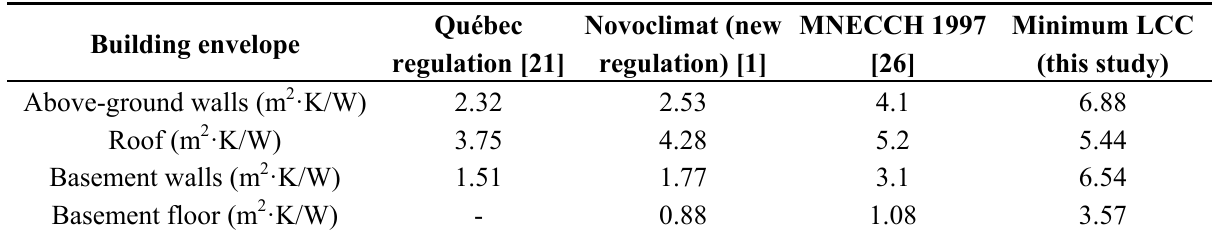
Table 6. A comparison of effective thermal resistance values for minimum LCC with some reference